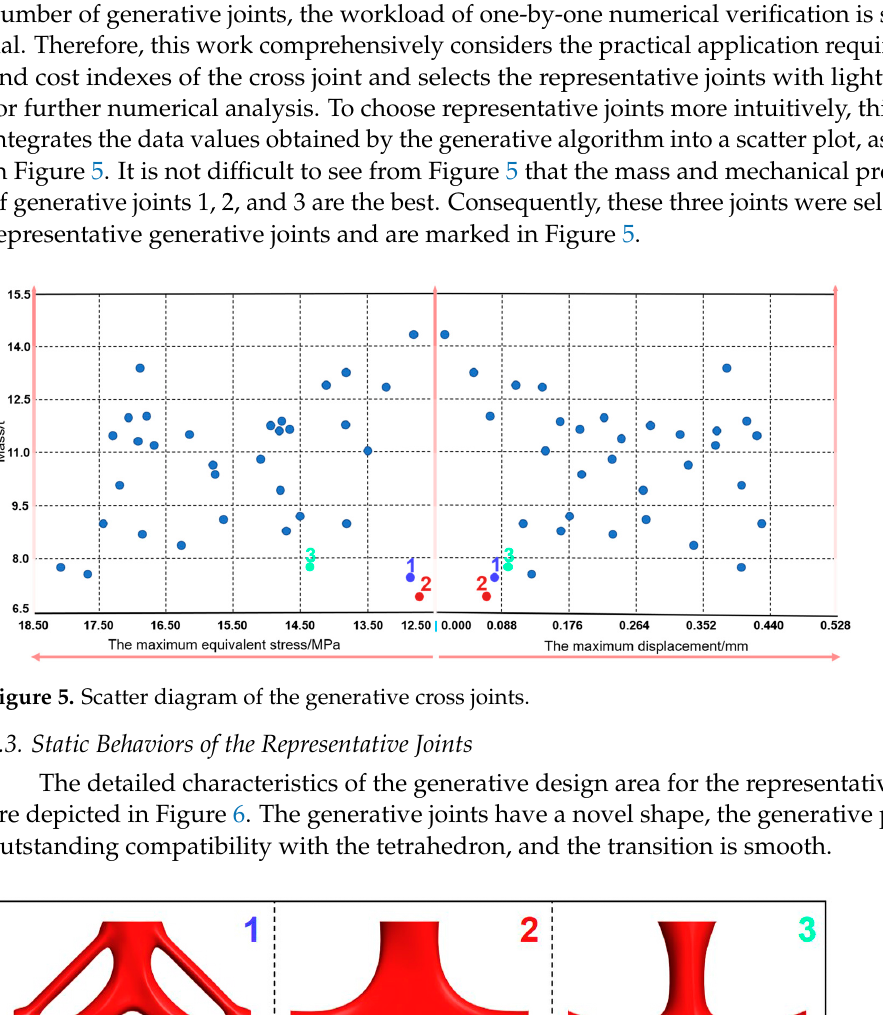
( b ) Figure 7. Static analysis results of generative joint 1: ( a ) displacement nephogram, ( b ) equivalent stress nephogram.